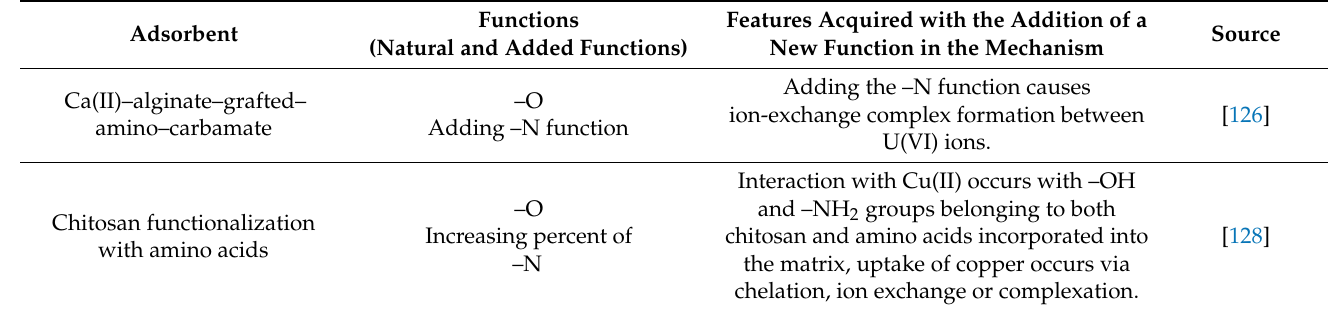
Table 2. Sorption features acquired with the addition of a new